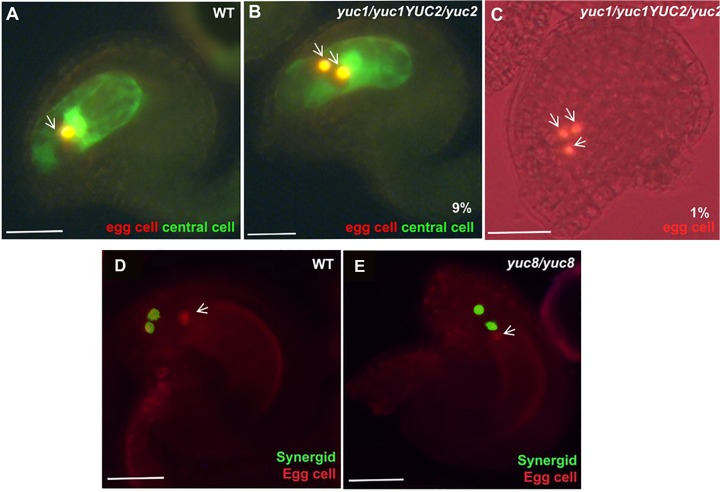
Changes in auxin homoeostasis lead to altered cell specification.
A, D, WT. B and C,
yuc1/yuc1 yuc2/YUC2. E,
yuc8/yuc8.A-C, green signal indicates the expression of central cell specific marker, and red indicates egg cell specific marker. The yellow color observed results from the overlapping of the red colour (egg or egg-like nuclei) on the green background of the central cell in the confocal image. D-E, green signal indicates synergid cell-specific marker, and red indicates egg cell-specific marker. A, WT ovule showing a single egg cell (Red) and a central cell (green) at FG7 stage. B, A mutant ovule at FG7 stage showing 2 egg cells and 1 central cell. C, an FG7 mutant ovule showing 3 egg cells. D, A WT ovule showing normal polarization of synergid nuclei towards the micropylar end. E, merged image of a yuc8 mutant ovule, showing miss-positioned synergids. The white arrows indicate the egg cell marker expression. Scale bar, 20 μM.